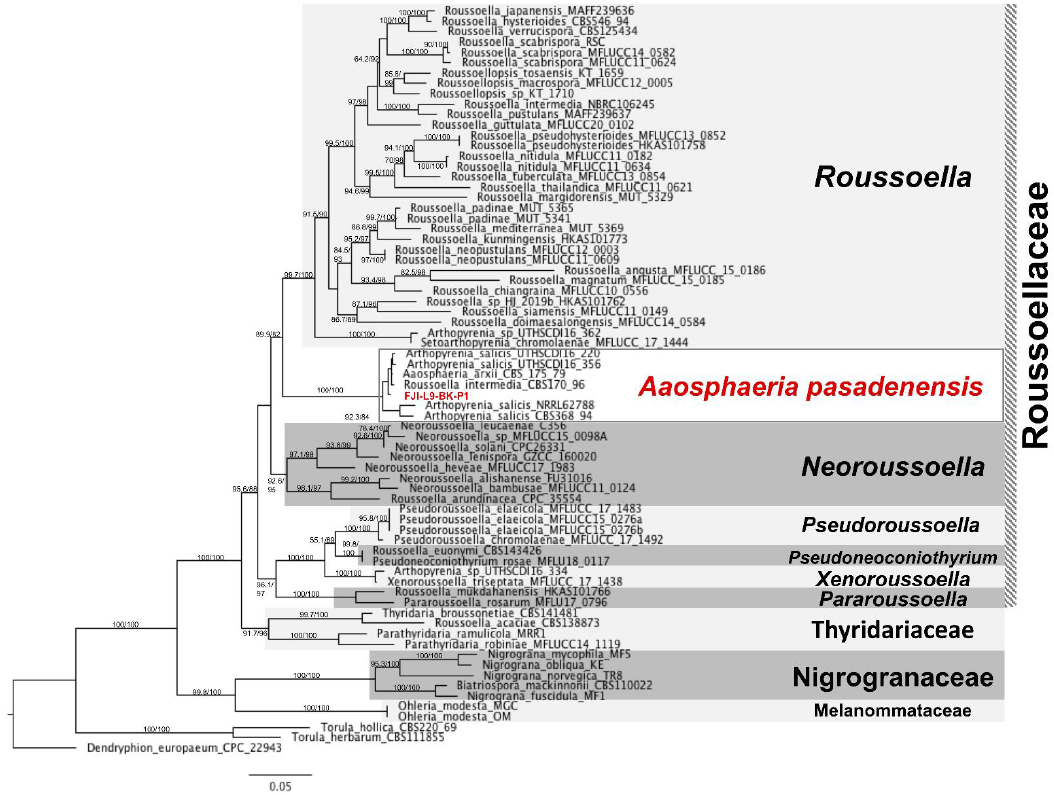
Figure 2. The MLST of A. pasadenensis . The genes ITS, LSU, RPB2, TEF 1 were used to investigate the phylogenetic placement of the A. pasadenensis via ML tree on the IQTREE2 software. The branches are proportional to the number of mutations and 1,000 ultrafast bootstraps and SH-aLRT was used to test branch support and were added to each corresponding branch of the tree. The tree was rooted with Dendryphion europaeum CPC 22943.